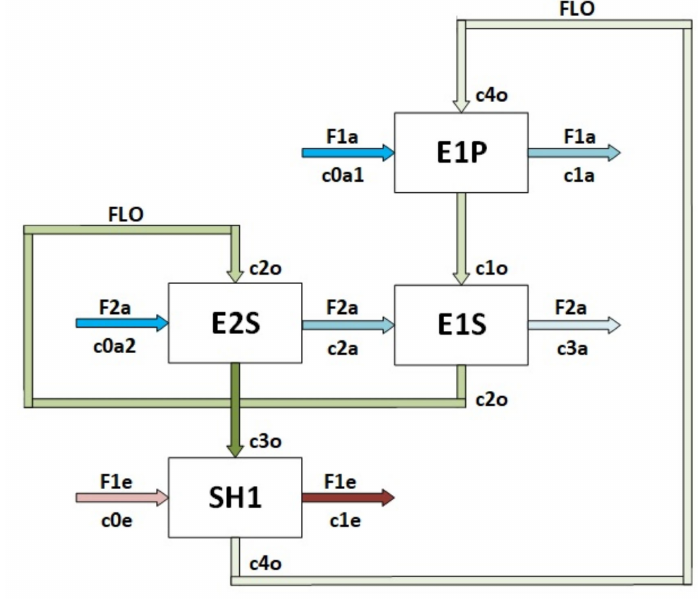
Figure 8. Schematic representation of SX process, adapted from